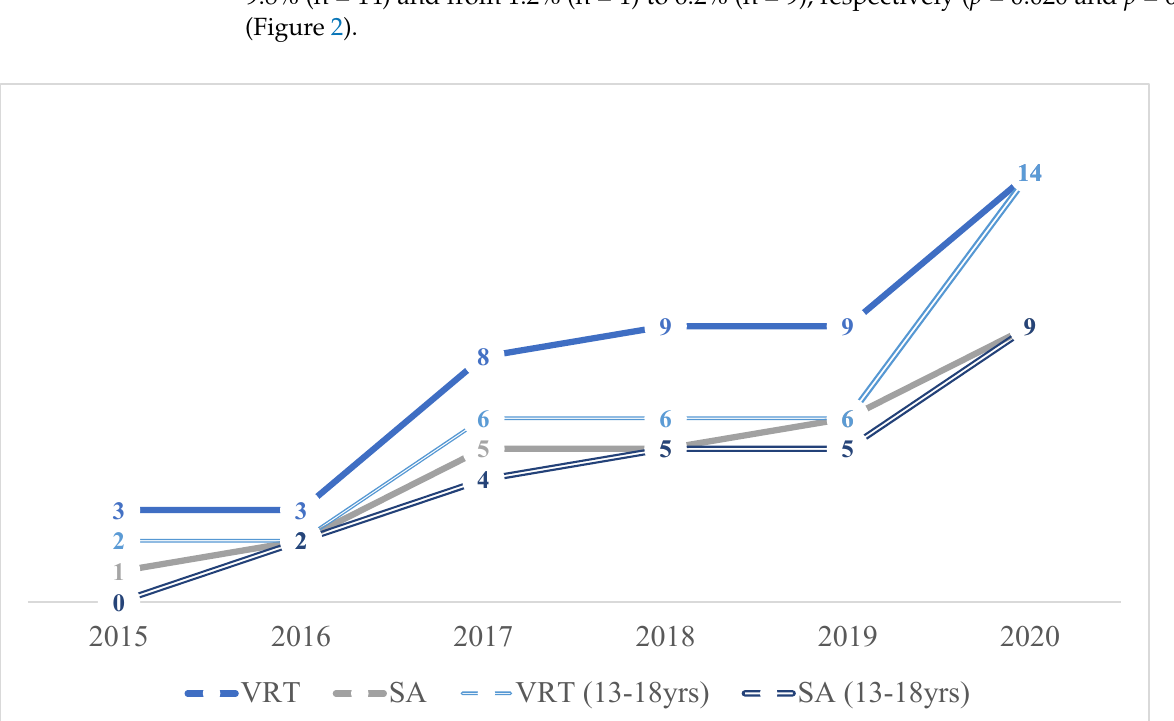
Figure 2. The trend of VRT and SAs in the overall population and the teenager subgroup. We found an increasing trend of VRT and SAs in the overall population over time. Moreover, we show how the most VRT and SAs happened in the teenager subgroup (13–18 years). Among SA patients (n = 28), fall-related injuries were the predominant mechanisms (92.9%, p < 0.001) (Figure 3). From the comparison analysis between the pre-pandemic group (2015–2019) and the COVID-19 group (2020), no differences in trauma intentionality or mechanisms were found ( p = 0.780 and p = 0.339), even though the highest rate of VRT and SAs was observed in 2020. The main change recorded during the pandemic period concerned the type and priority code of ED access, with a higher number of self-presenting patients accounting for a higher number of green codes at triage in detriment of red ones.